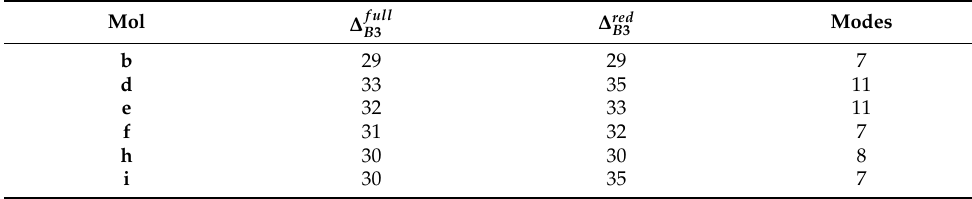
Figure 4. Comparison between experimental frequencies of NO stretchings and the counterparts issued from scaled harmonic (B3 in orange and B2 in light blue) and anharmonic (B3 in red and hybrid in dark blue) frequencies. The scaling factors are 0.976 and 0.980 for ω B 3 and ω B 2 , respectively. Vertical lines separate the different nitroxide families defined in the main text. Table 5. Reduced dimensionality results obtained employing a K iij / ω i threshold of